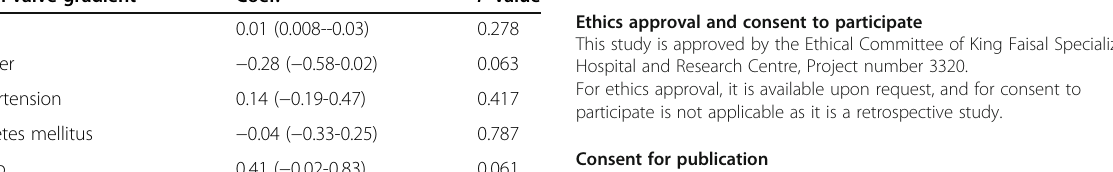
Table 6 Factors affecting the change of the mitral valve gradient Mitral valve gradient